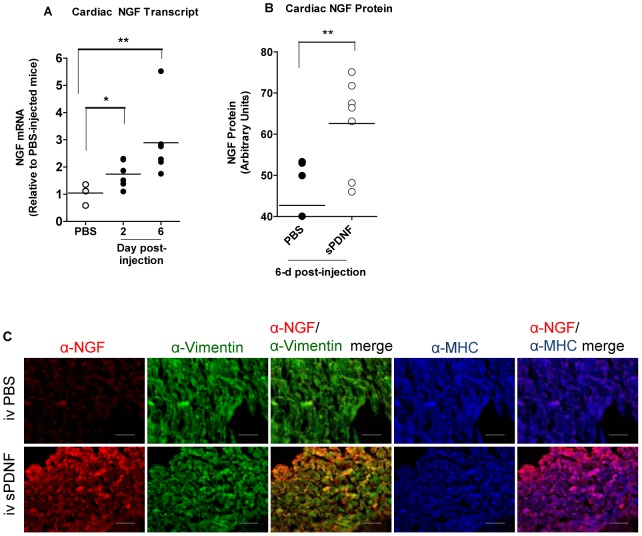
Intravenous administration of PDNF upregulates nerve growth factor in the heart selectively on cardiac fibroblasts.
A) Intravenous sPDNF upregulates NGF transcript in the heart of C57BL/6 mice. Mice (2–3/point) were injected with vehicle (PBS) or sPDNF intravenously (IV) (25 µg per mouse) daily for 2 or 6 days, sacrificed one day after the last injection, and their cardiac (atria) NGF transcript levels measured in duplicate by qPCR and compared to mice injected with IV PBS for 6 d. Results are representative of three similar experiments; *, P<0.05; ** P<0.01, ns, not statistically significant. B) Intravenous sPDNF upregulates NGF protein in the heart of C57BL/6 mice. Mice (2–3/point) were injected with sPDNF intravenously (25 µg per mouse) or vehicle for 6 d, sacrificed one day after the last injection, and their cardiac (atria) NGF protein levels ascertained by immunofluorescence using the NIH ImageJ software, n = 3–7, composite of two distinct experiments. C) NGF is preferentially localized in cardiac fibroblasts following intravenous injection of sPDNF. Representative images of heart (atria) tissue sections from the results presented in B) above. Note that iv sPDNF robustly increase NGF (leftmost panels) that co-localizes primarily with the cardiac fibroblasts (α-NGF/α-vimentin merge).